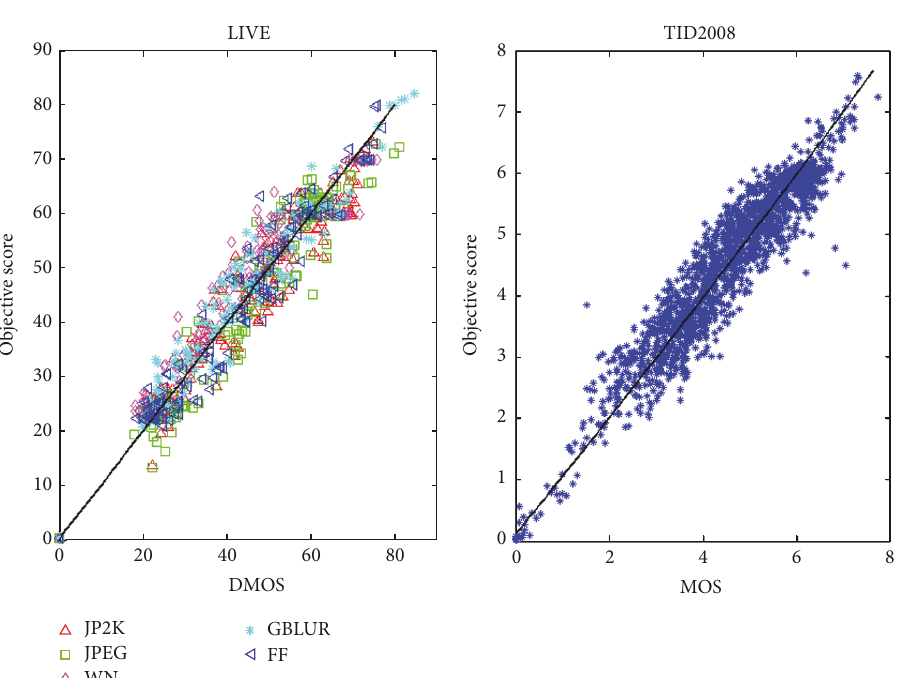
Figure 7: Scatter plots on LIVE and TID2008